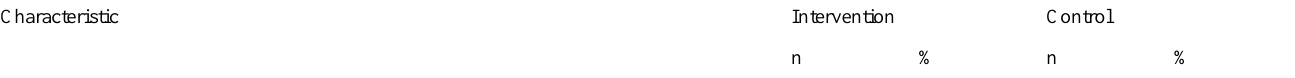
DUMMY TABLE - CELLS INTENTIONALLY EMPTYAge